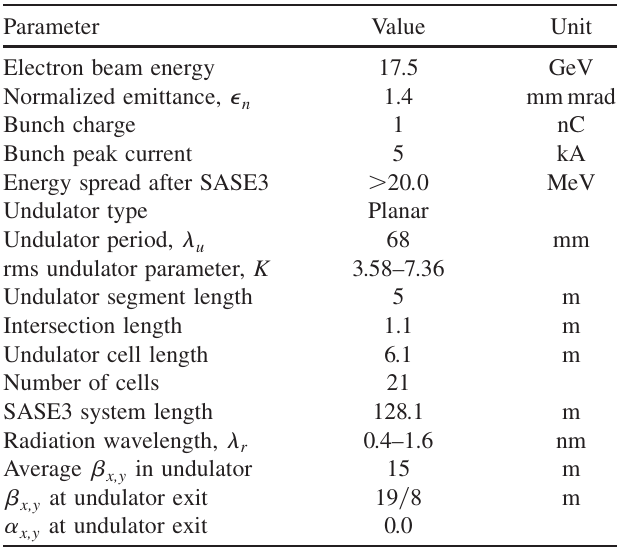
TABLE I. Parameters of the European XFEL and the SASE3 undulator